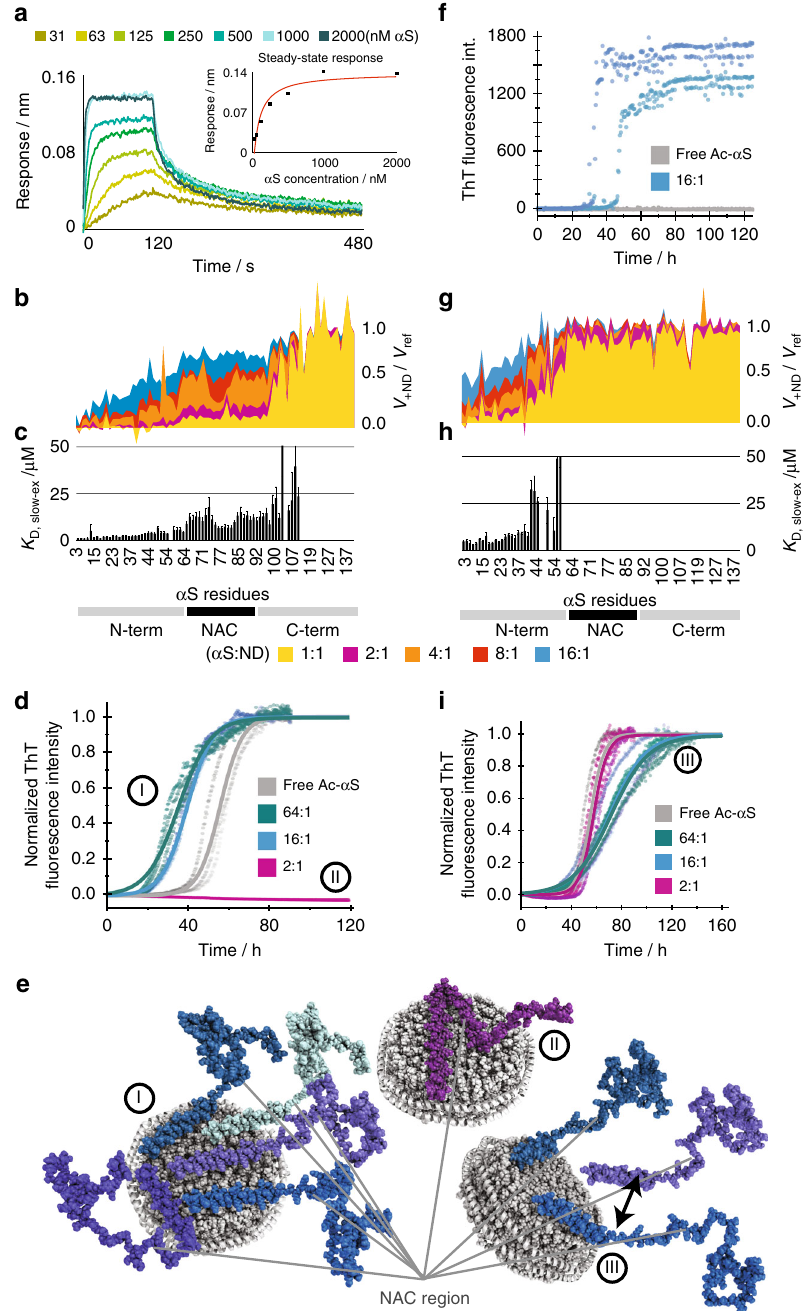
Fig. 5 The interplay between interaction kinetics, differential residue speci fi c af fi nities, membrane charge density and accessible surface area modulates α S aggregation. a BLI sensorgrams obtained with immobilized 100% POPG NDs and addition of different concentrations of α S. Corresponding steady-state response plot are shown as insert. A fi tted global af fi nity ( K D ) of 67 ± 17 nM and a fi tted off-rate of 0.015 ± 0.006 s − 1 could be extracted. b NMR attenuation pro fi les of a titration of 50 µ M α S with varying concentrations of 100% POPG NDs ( α S-to-NDs molar ratios ranging from 16:1 to 1:1, see color code). c Corresponding residue-speci fi c af fi nities extracted from NMR titration data. The values report on the slow-exchange (lower) limit for the af fi nities (see text for details). d Normalized ThT fl uorescence aggregation curves for selected α S-to-ND ratios (conditions identical as in b – g ). e NMR-derived binding modes and their link to the indicated aggregation behaviour (see Supplementary Note 3 for more details on how binding models were generated). Although high amounts of NDs with high charge density inhibit aggregation (binding mode II), limited amounts of highly charged membrane surfaces enhances aggregation (binding mode I). For NDs with a moderate lipid charged density, only one α S-binding mode was observed that has little effect on aggregation (binding mode III). f Nucleation ThT assays in quiescent conditions at pH 5.3. Although under these conditions no aggregation is observed in the absence of NDs (duplicates in gray), the presence of 16:1 molar ratio of 100% POPG NDs (duplicates in light and dark blue) induces primary nucleation. g – i Same as data shown in b – d but using NDs with 50% POPG